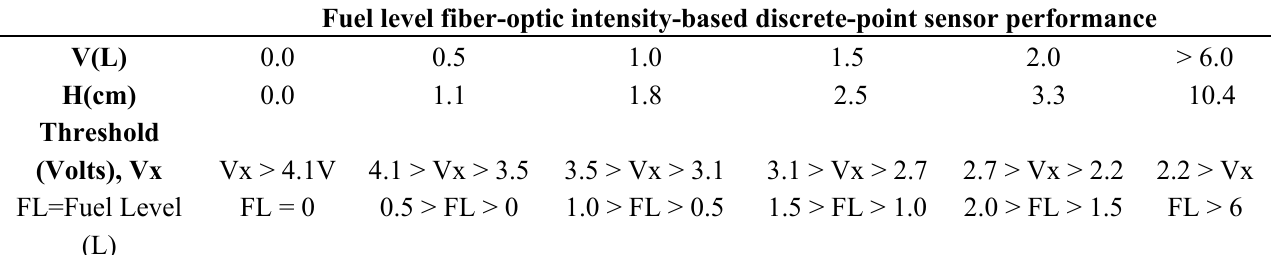
Table 4. Volume of fuel (in L), V(L), and corresponding heights (in cm), H(cm), inside the tank. Decision criteria (threshold voltage) implemented at the control electronics